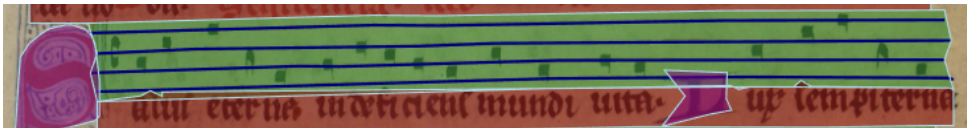
Figure 5. Example of the layout detection. Red regions are lyric regions. Green areas are music regions and purple areas are drop capital regions. We divided the drop capitals into two classes. Big ornated (left one) and smaller ones, which still clearly intrude the music regions (right